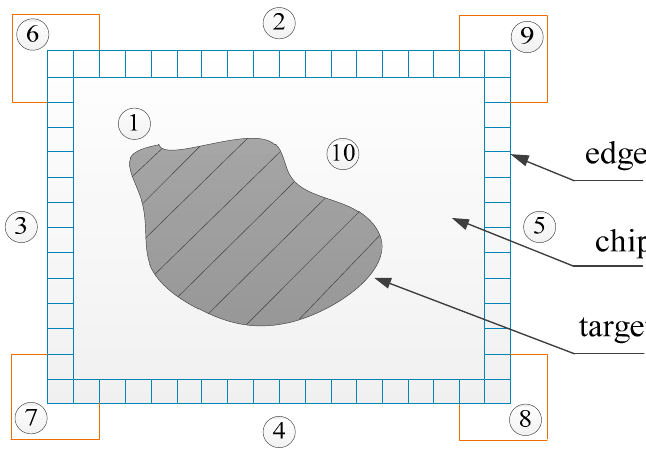
Figure 10. The illustration for the ten judgment conditions.